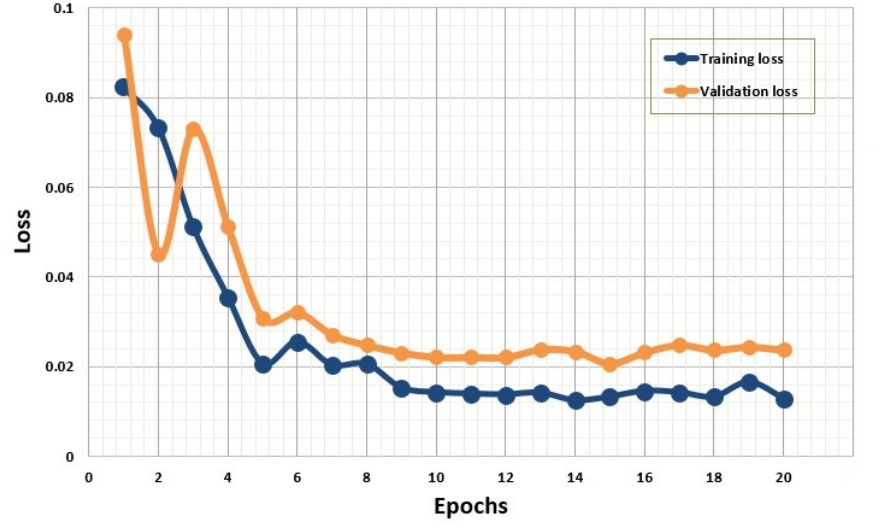
Figure 4. The loss curves of the proposed model.